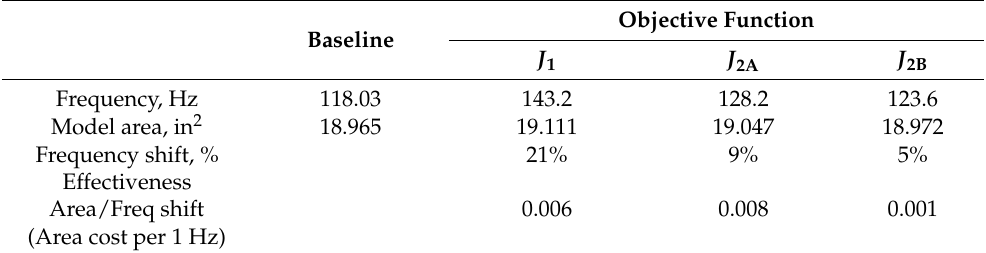
Figure 22. Optimization summary results with baseline for reference. Table 8. Results of the optimization